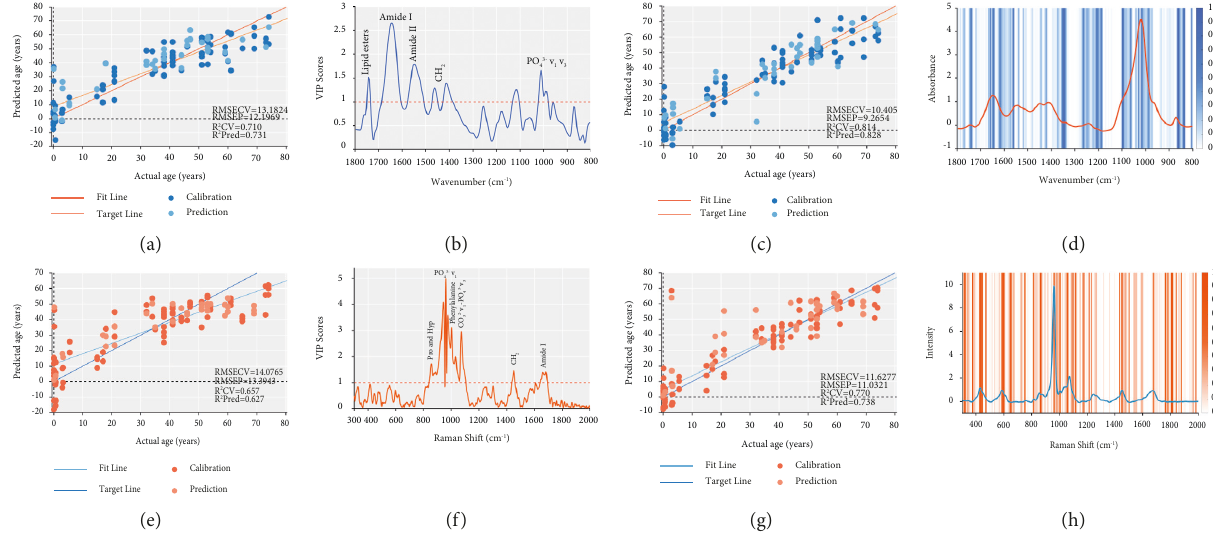
Figure 4: PLS and GA-PLS regression models of FTIR and Raman age estimation. The dark color dots represent the calibration datasets, and the light color dots represent the prediction datasets. The dark color line is the target line corresponding to the perfect prediction, while the light color line is the model fitting line. (a) FTIR PLS regression model. (b) FTIR PLS regression model VIP scores plot. (c) FTIR GA-PLS regression model. (d) FTIR variables selected by GA (blue shades). (e) Raman PLS regression model. (f) Raman PLS regression model VIP scores plot. (g) Raman GA-PLS regression model. (h) Raman variables selected by GA (orange